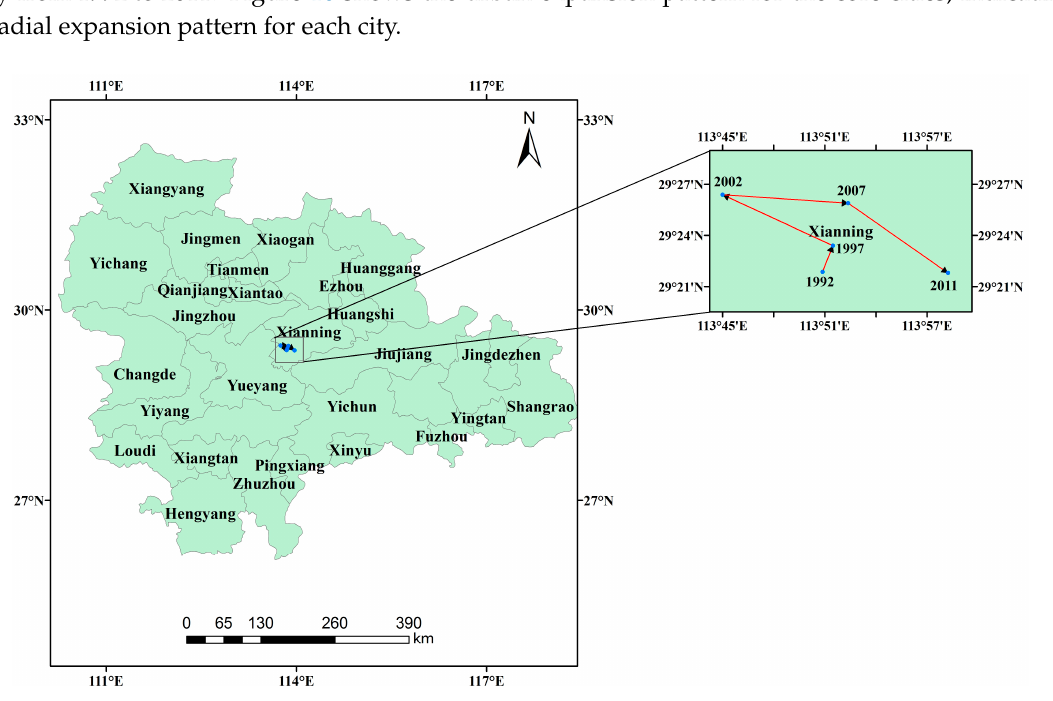
Figure 8. The trajectory of the gravity center of the urban area in the city cluster from 1992 to 2011.